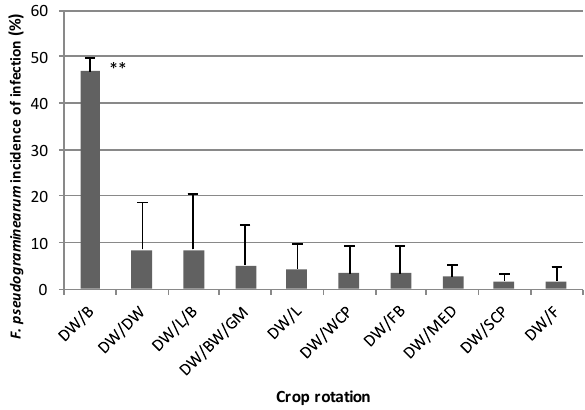
Figure 2. Impact of previous crops on Fusarium pseu- dograminearum incidence of infection in durum wheat roots of plants grown at in the Experimental Station of INRAT at Kef during the 2009–10 cropping season. Error bars are 2 × standard deviation. **: highly significant dif - ference ( P <0.001) compared to mono-cropping of durum wheat according to the Student test. DW: durum wheat; BW: bread wheat; B: barley; F: fallow; FB: faba bean; L: lentil; WCP: winter chickpea; SCP: spring chickpea; MED: medic; GM: green manure (faba